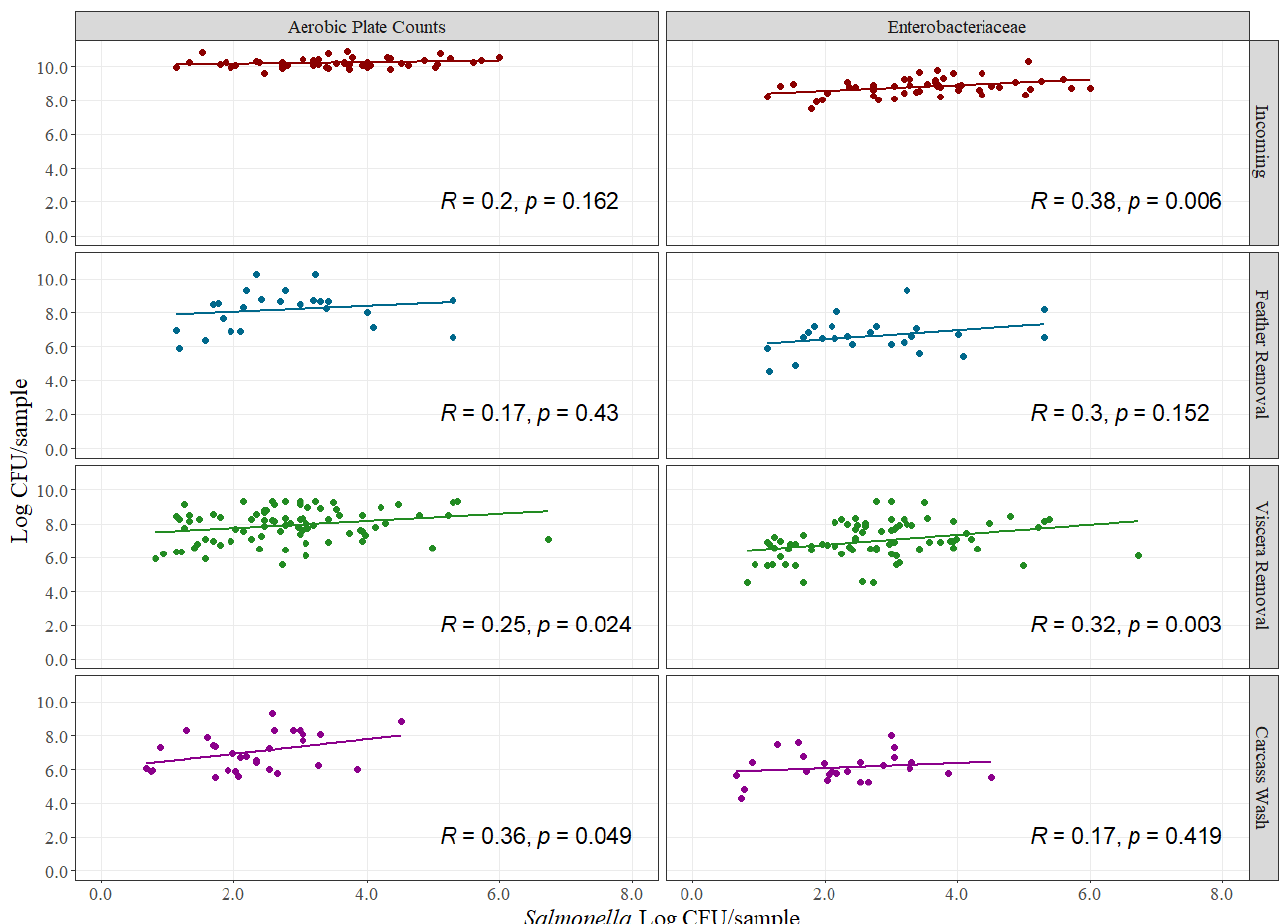
Figure 3. Pearson’s correlation analysis between Enterobacteriaceae ( right ) and mesophilic aerobic counts ( left ) (Log CFU/sample) with Salmonella counts (Log CFU/sample) at each of the four com- bined sampling locations on whole carcass chicken rinses. The points represent the actual data points.